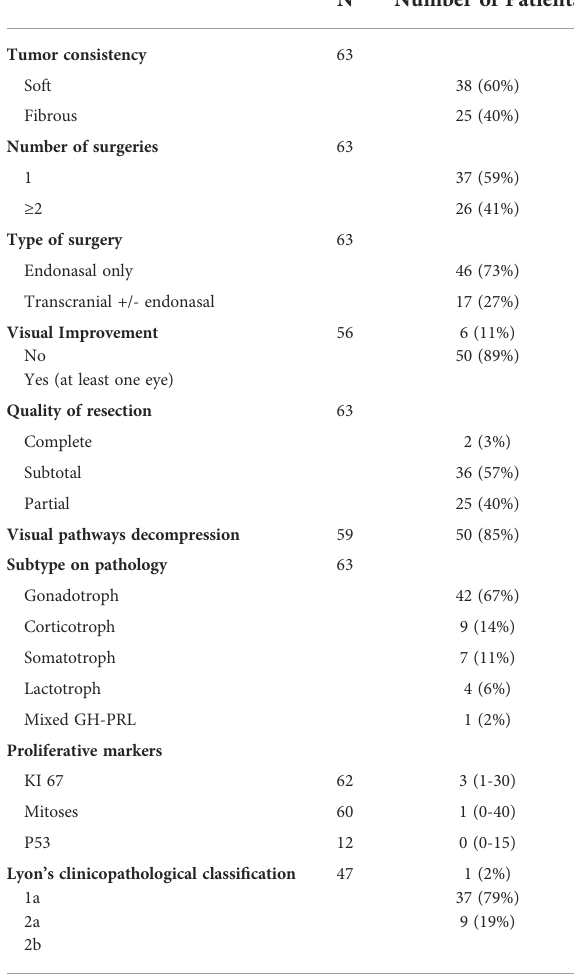
TABLE 2 Peri-operative characteristics of 63 patients treated for a giant pituitary adenoma.